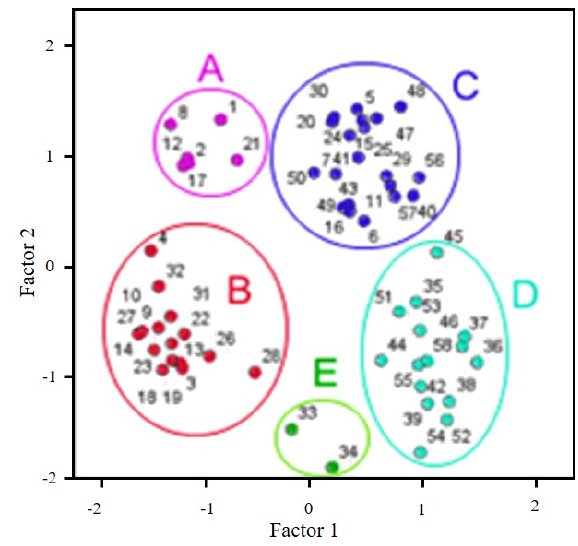
Figure 2. Principal Component Analysis for red wines.